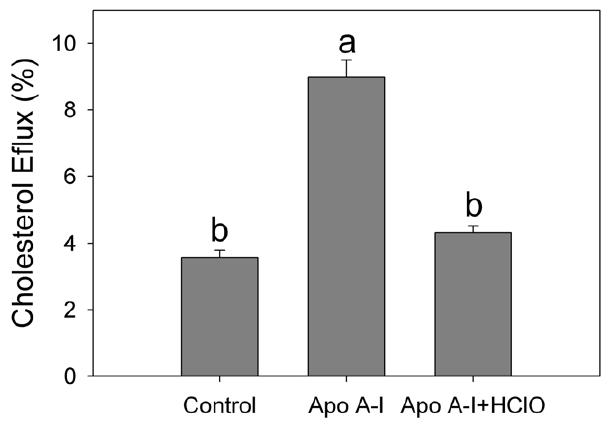
Figure 10. Helical wheel model of putative A a -helix comprised between amino acid residues 147 and 163 of apoA-I. Helix is seen down the long axis, and representing an amino acid arrangement considering an ideal a - helix (l00 u rotation per residue). Gray scale in the figure corresponds to the nature of different amino